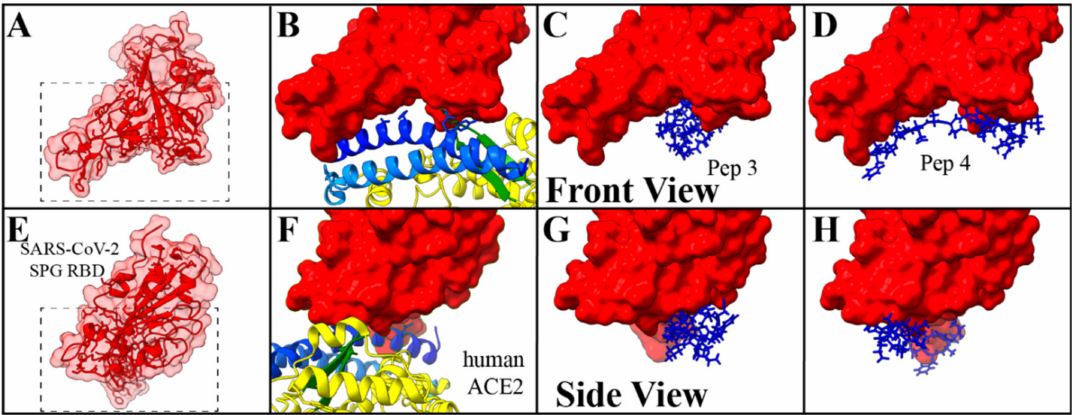
Figure 5. Molecular docking studies with SARS-CoV-2 SPG RBD. Zoomed out front ( A ) and side ( E ) perspective of the RBD, with the extent of the electrostatic potential surface shown in transparent red. A dashed box is provided which highlights the window used in the other images ( B – D , F – H ). The results of the docking simulation between the SARS-CoV-2 spike glycoprotein RBD and human ACE2 ( B , F ), Peptide 3 ( C , G ), and Peptide 4 ( D , H ) are provided for each perspective, with the RBD surface presented in solid